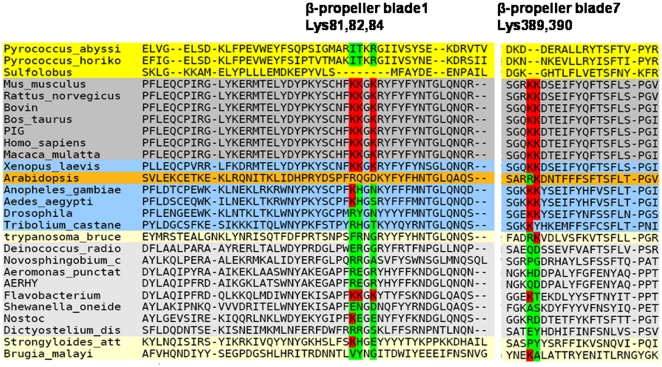
Conservation of lysine residues across lower to higher organisms.Lysines were conserved in all mammalian species and also in amphibian Xenopus. Coloring: Archaebacteria (yellow), mammals (dark grey), amphibian (blue), plants (orange), arthropods (blue, below orange), nematodes (light yellow), bacteria (light grey). Presence of lysines are shown using red color, while absence using green color.